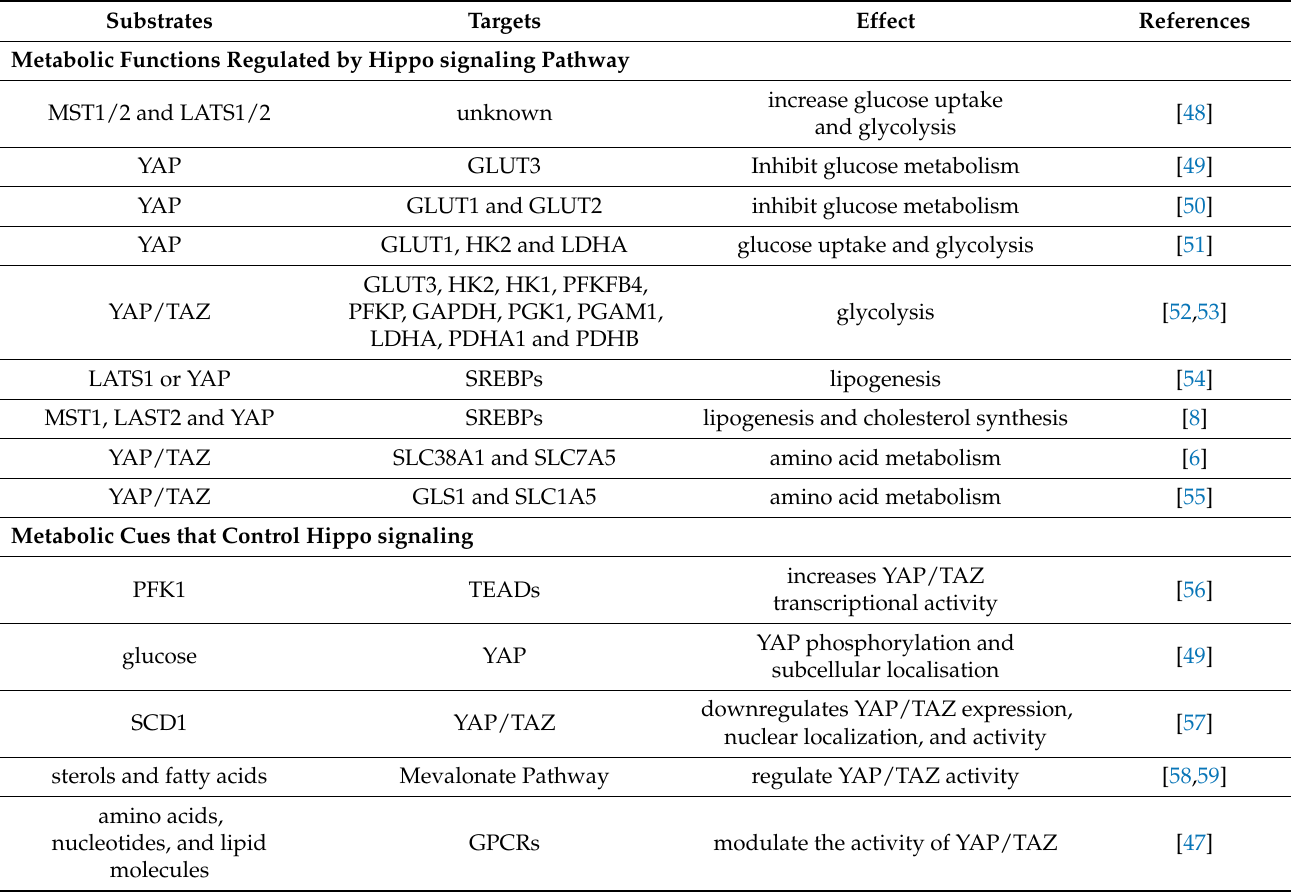
Table 1. Integration of Hippo-YAP signaling with